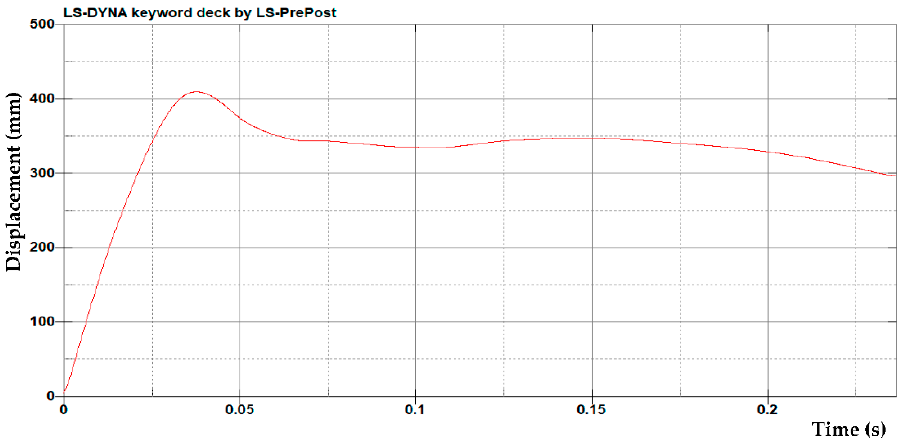
Figure 6. Displacement of the armored vehicle in the X -axis.